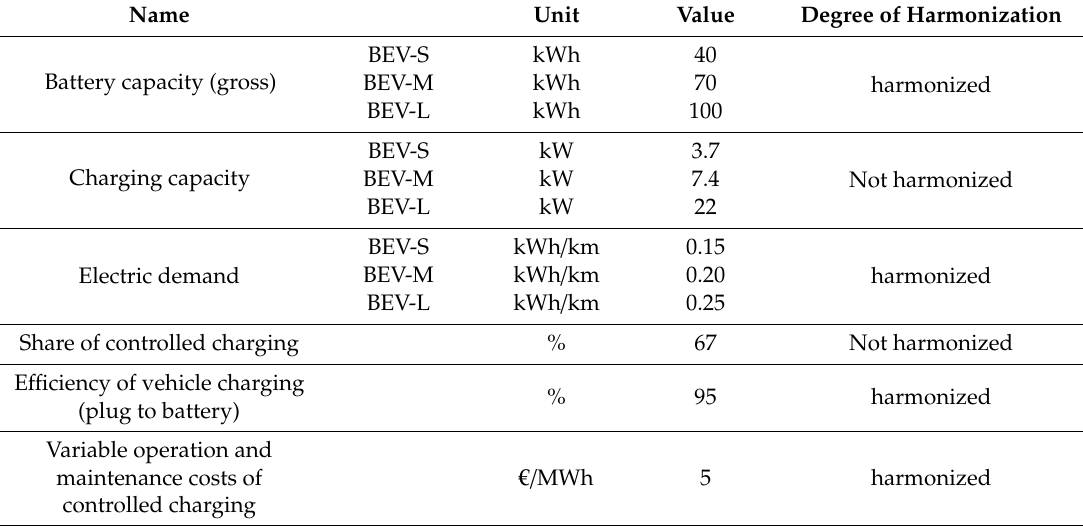
Table 4. Technology assumptions for EVs for scenario S1 and respective degree of harmonization with scenario S2 input assumptions. Battery capacity values are assumed based on a comparison of historic battery sizes and literature projections from [18,20,28,41,42].